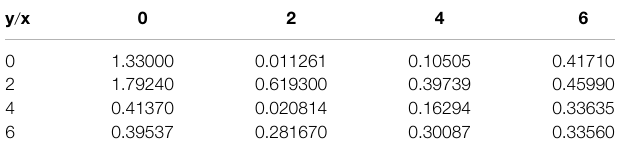
TABLE 2 | Data from function F 1 ( x , y )